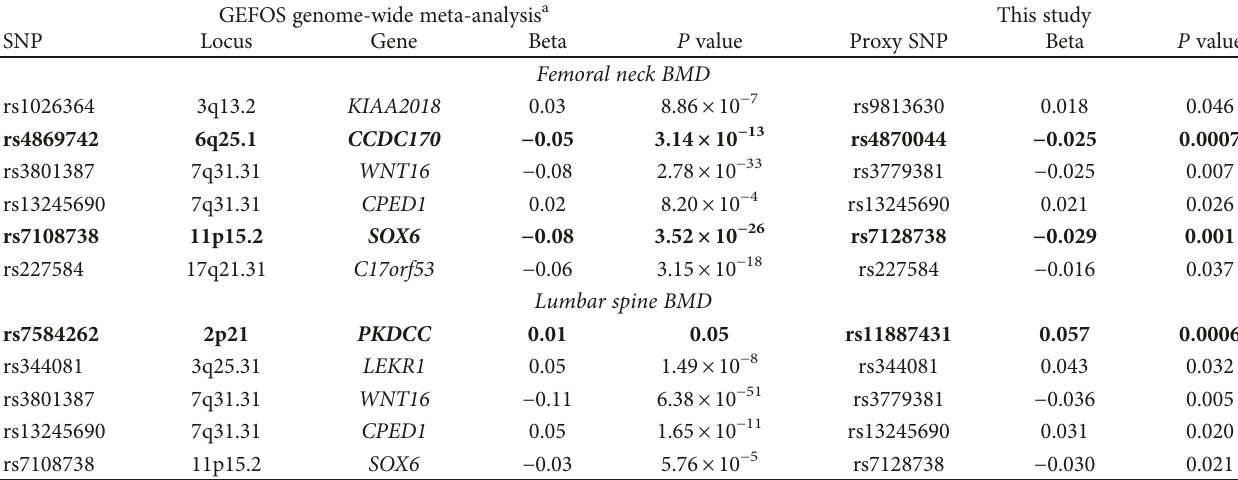
Table 3: Comparison of SNP e ff ect sizes for BMD between GEFOS genome-wide meta-analysis and this study. GEFOS genome-wide meta-analysis